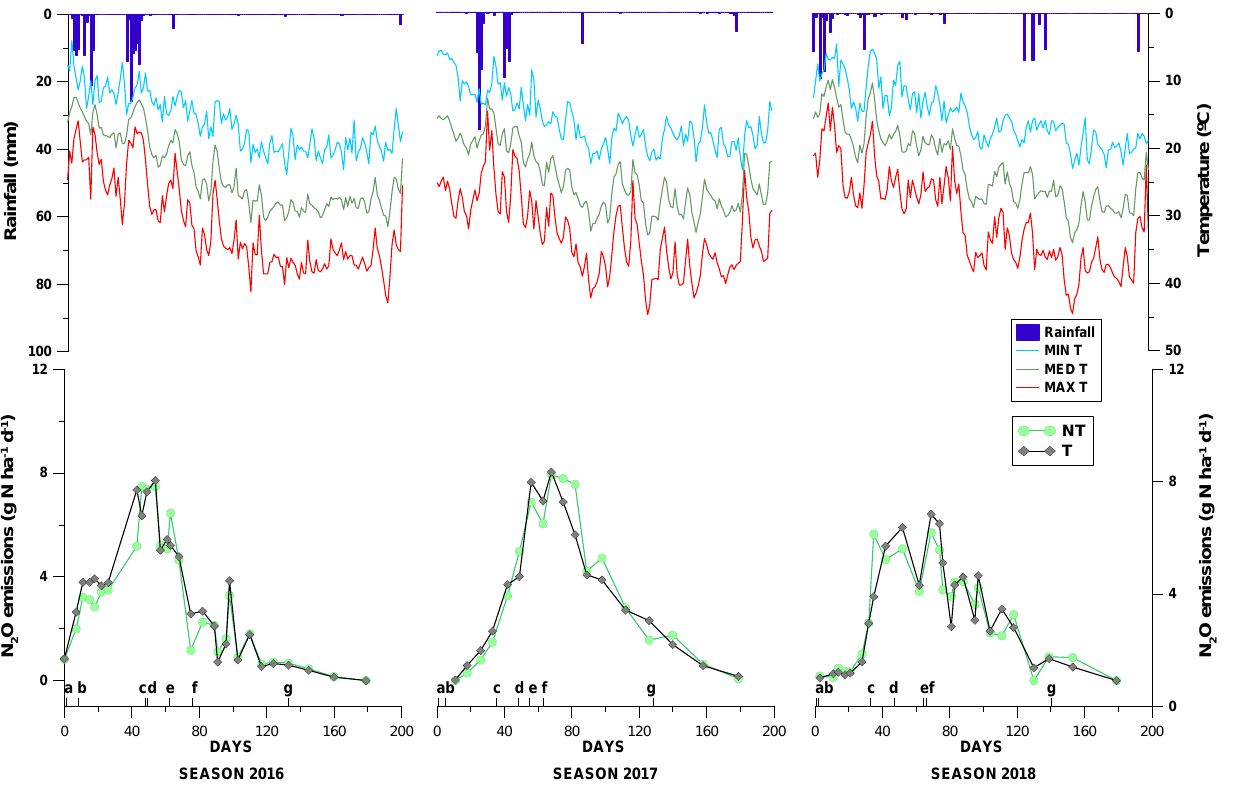
Figure 2. Daily emission of N 2 O according to the implemented management system. The different letters indicate: a = seeding; b = first fertilisation with DMPP; c = first fertilisation with U and AN; d = second fertilisation with DMPP; e = second fertilisation with U and AN; f = first irrigation; g = last irrigation.